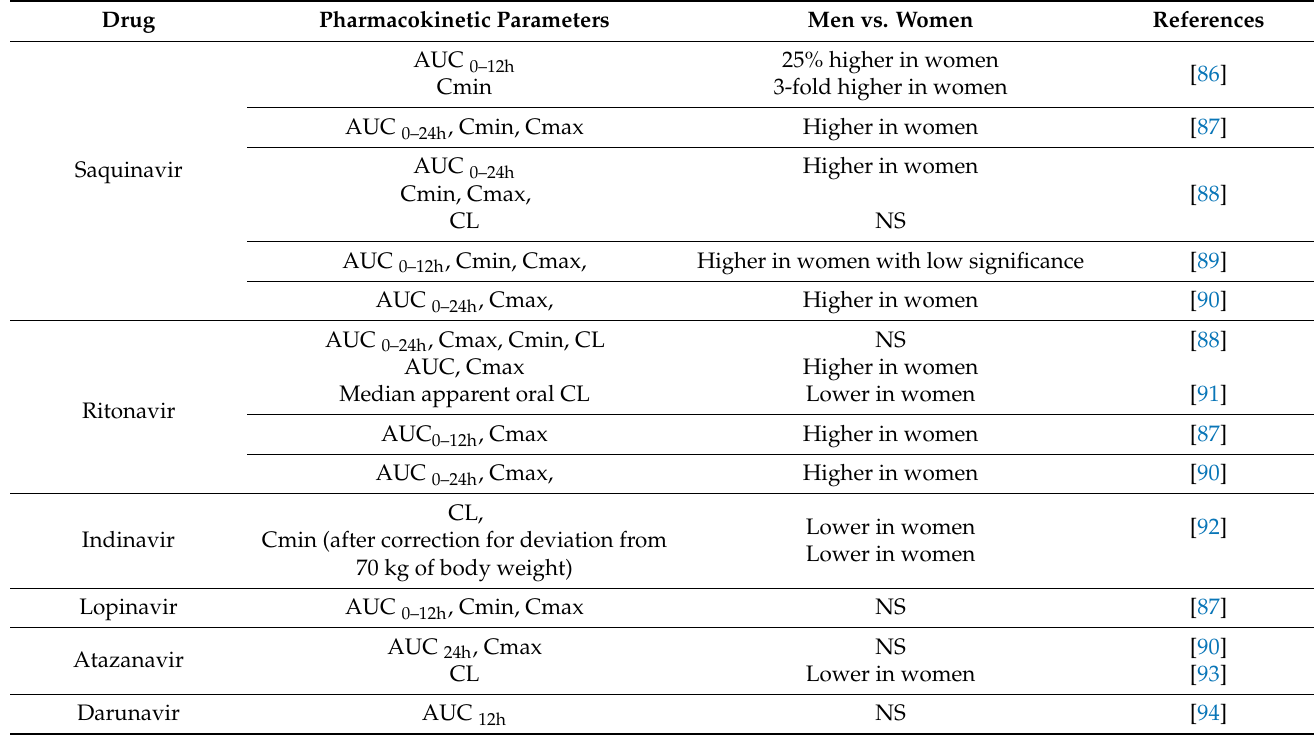
Table 1. Pharmacokinetic of some protease inhibitors in the presence of ritonavir in non-COVID-19 patients: effect of sex. Drug Pharmacokinetic Parameters Men vs.